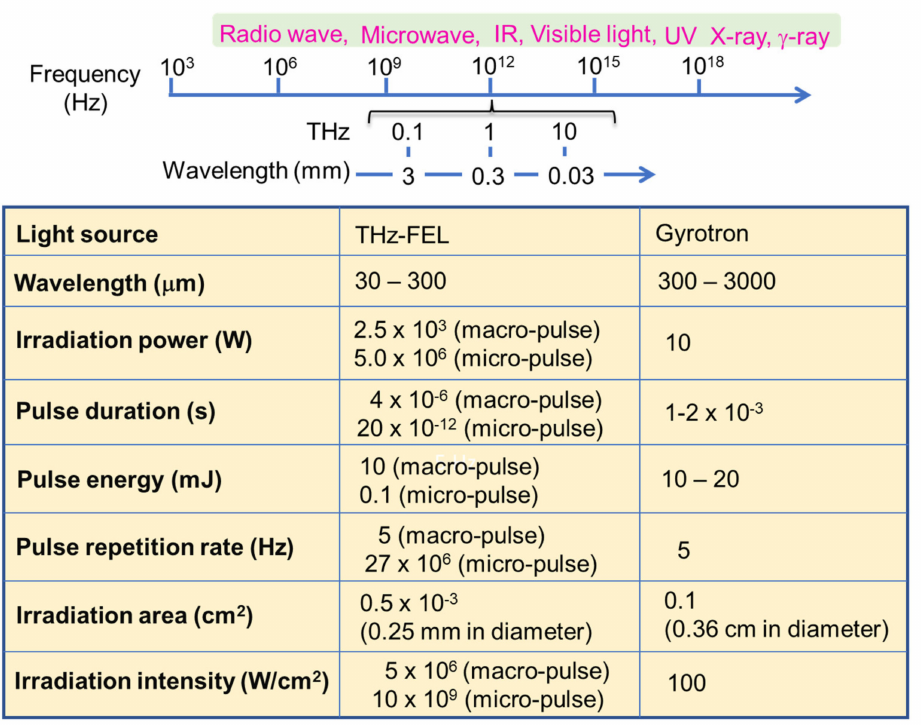
Figure 1. Frequency region of electromagnetic waves (upper) and far-infrared radiation parameters used in this